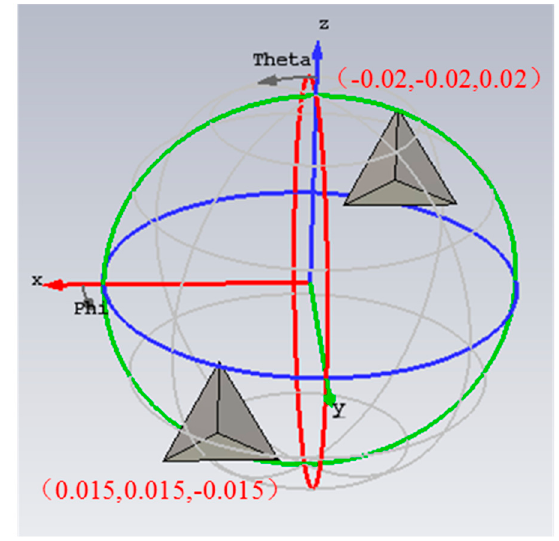
Figure 11. 3-D CAD model of two adjacent trihedral.